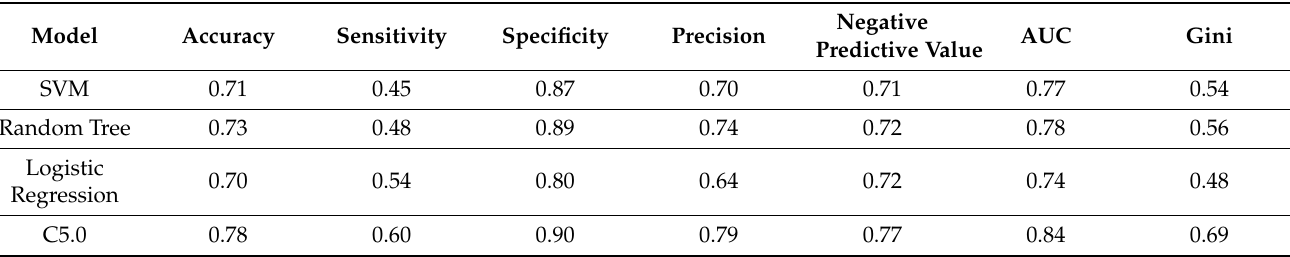
Table 1. Results of the classification performance of different machine-learning models using the resting dataset. Model